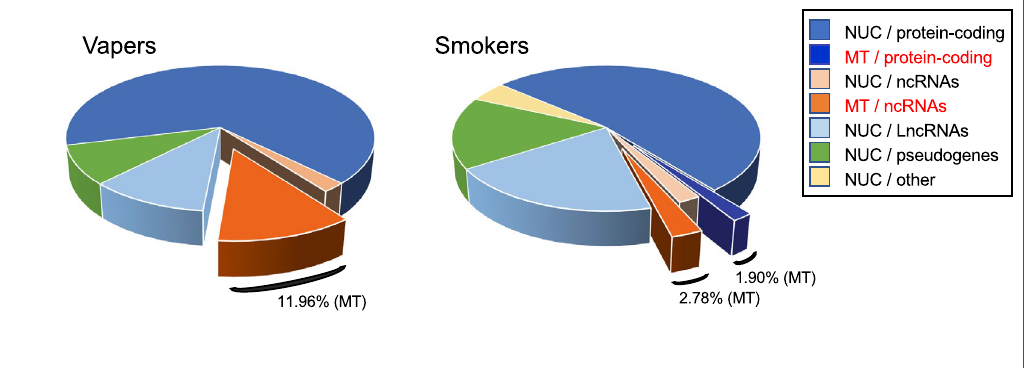
92; > 1.5 fold-change and FDR < 0.1). The DEGs in vapers consisted of 59 up-regulated (64.1%) and 33 down- regulated (35.9%) genes (Fig. 1A). In smokers, there were 471 up-regulated (69.0%) and 212 down-regulated (31.0%) genes (Fig. 1A). Detailed lists of the DEGs in vapers and smokers, along with other relevant information, are provided in Supplementary Tables S1 and S2, respectively. Of the 92 DEGs identified in vapers, 61 are protein-coding genes (66.3%), while the remaining 31 DEGs (33.7%) transcribe for regulatory non-coding RNAs (both short- and long non-coding RNAs) and non-functional elements, including pseudogenes (based on the GENCODE & Ensembl gene/transcript biotype classification) (Fig. 1B). In smokers, 374 of the 683 DEGs (54.8%) are protein-coding, while the remaining 309 DEGs (45.2%) belong to several classes of gene/transcript biotypes, including short non-coding RNAs (ncRNAs) (4.8%), long- non-coding RNAs (lncRNAs) (19.9%), pseudogenes (16.0%), and other elements of unknown function (4.5%) (Fig. 1B). Collectively, vapers, as compared to smokers, have an over-representation of protein-coding DEGs and an under-representation of non-protein-coding DEGs ( P = 0.047; Yates corrected Chi-square test). Of sig- nificance, 12.0% of DEGs in vapers (11 out of 92) are of mitochondrial origin, including one DEG that encodes mitochondrial ribosomal RNA (MT-rRNA) and 10 DEGs that code for mitochondrial transfer RNAs (MT- tRNAs) (both classified as ncRNA sub-types). In smokers, however, 4.7% of DEGs (32 out of 683) consist of mitochondrial genes, which include 13 protein-coding genes, two MT-rRNAs, and 17 MT-tRNAs. Of these, nine are common to vapers, including one MT-rRNA and eight MT-tRNAs. Although the proportion of mitochondrial DEGs in smokers is smaller than that in vapers, the absolute number of dysregulated mitochondrial genes in smokers (32) is remarkable considering that the mitochondrial genome consists of only 37 genes 24 . Of these, 13 genes are protein-coding and the remaining 24, including two MT-rRNAs and 22 MT-tRNAs, are used for the translation of those 13 polypeptides 24 . Notably, all the dysregulated mitochondrial genes (protein-coding and non-coding) in both vapers and smokers are over-expressed (Supplementary Tables S1 and S2). Figure 1C is a Venn diagram of the DEGs identified in vapers and smokers as compared to controls. Overall, there are three categories of DEGs in vapers and smokers as compared to controls: (1) vape-specific DEGs: genes differentially expressed in vapers only; (2) smoke-specific DEGs: genes differentially expressed in smokers only; and (3) common DEGs: genes differentially expressed in both vapers and smokers. The vape-specific DEGs